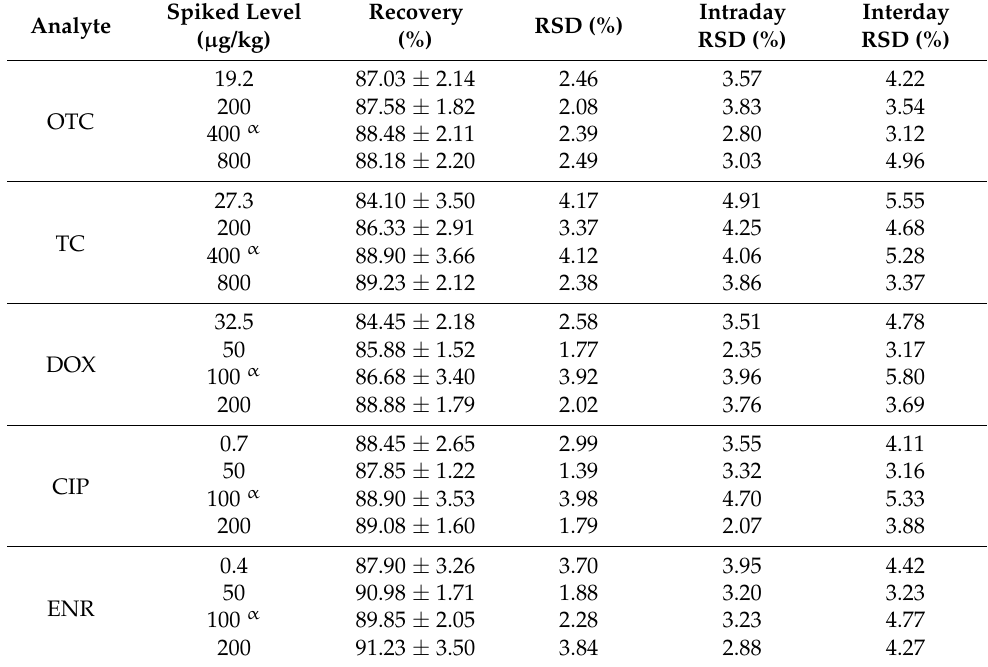
Table 6. Recovery and precision for analyses of blank duck albumen spiked with OTC, TC, DOX, CIP and ENR (n = 6).